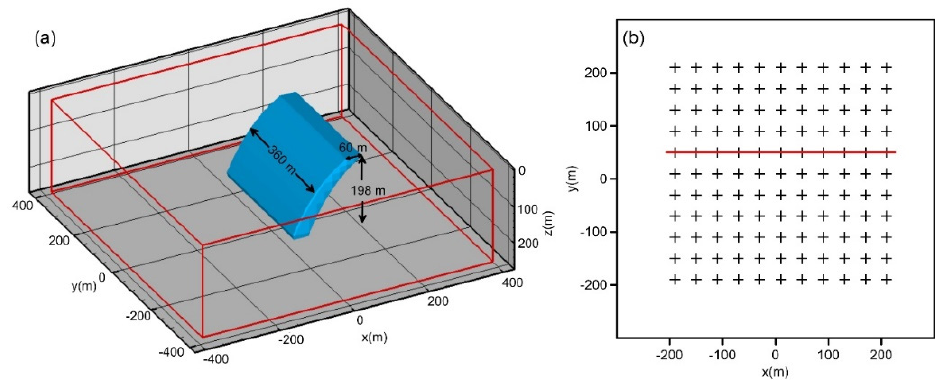
Figure 3. ( a ) A synthetic model; ( b ) distribution of measuring points (the red line is at y = 50 m).